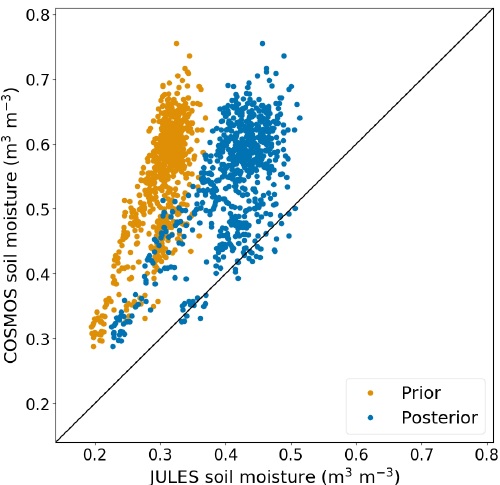
Figure 6. Observed vs. modelled (ensemble mean) soil moisture at Gisburn Forest (GISBN) for prior and posterior JULES runs. The diagonal line shows the 1 : 1 perfect correspondence line. The cor- relation coefficient at this site changed from 0.73 (prior) to 0.69 (posterior), and the RMSE reduced from 0.25 (prior) to 0.15 (pos-